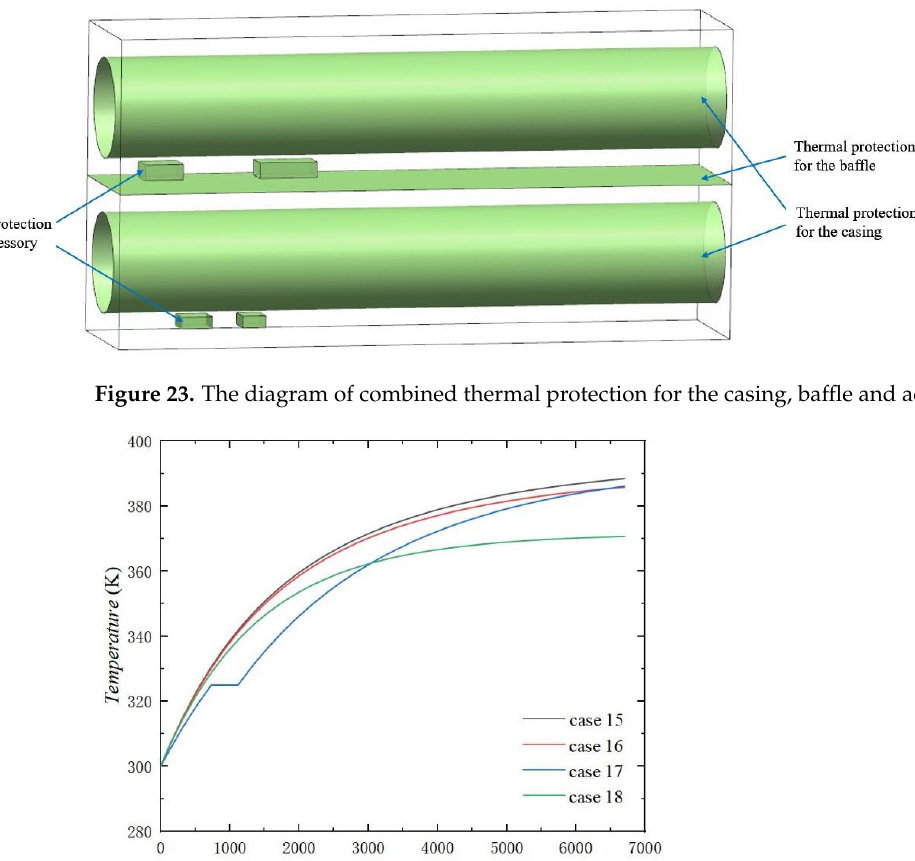
Figure 23. The diagram of combined thermal protection for the casing, baffle and accessory. Figure 24. Temperature of accessory 1 when the casing, baffle, and accessory were thermally pro-